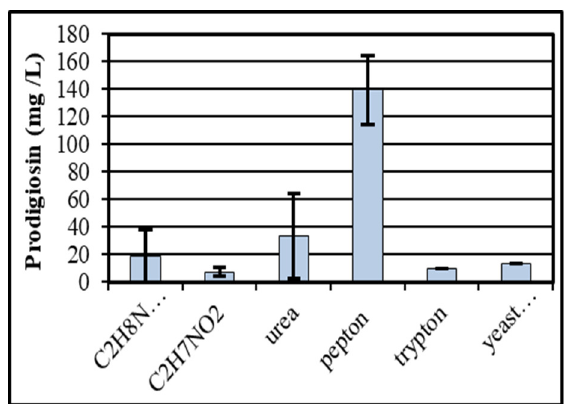
Fig. 2. The effect of nitrogen sources on prodigiosin production by S. marcescens in chemically defined liquid medium.